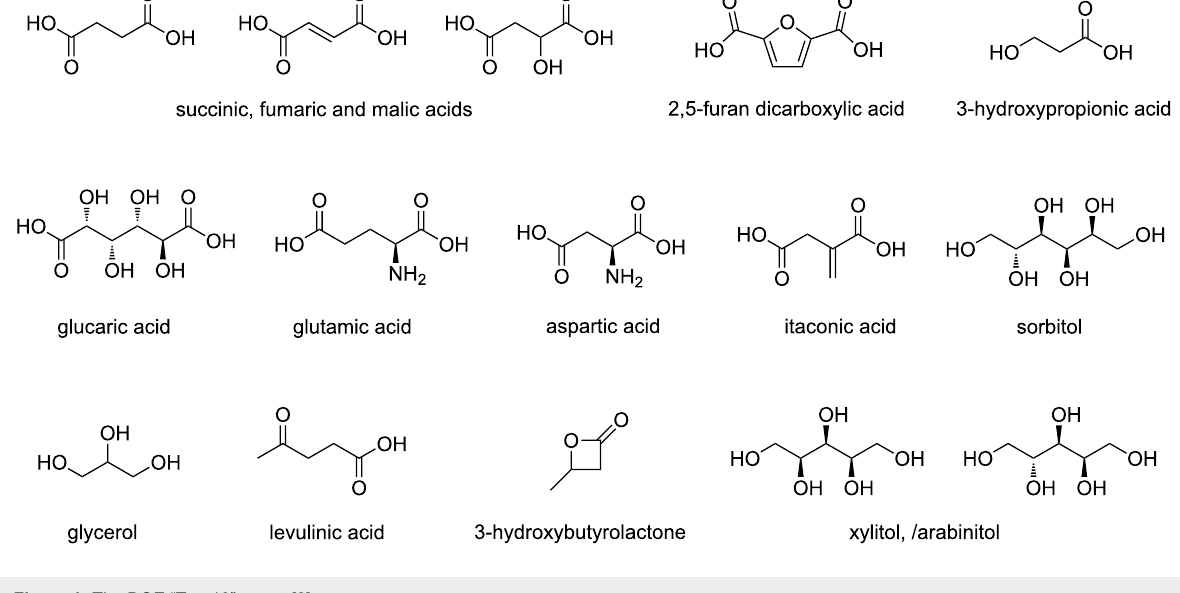
Figure 1: The DOE “Top 10” report [2].